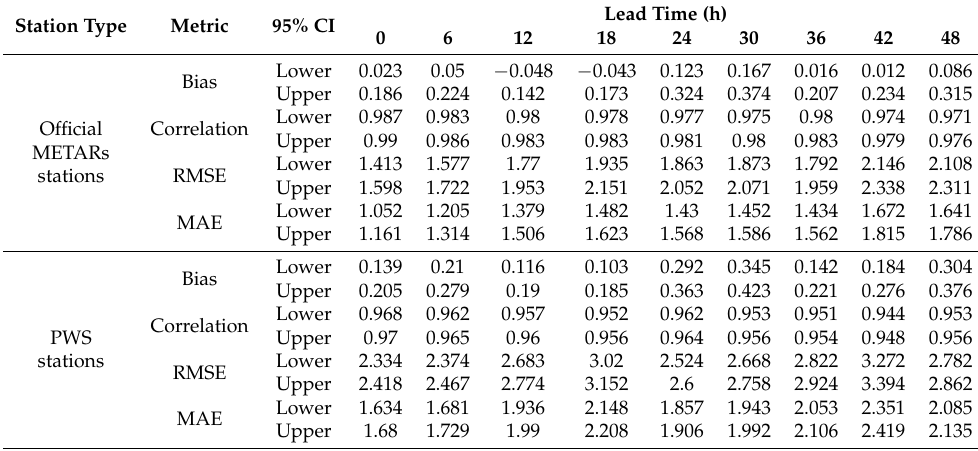
Table 2. Bootstrap confidence intervals of the verification